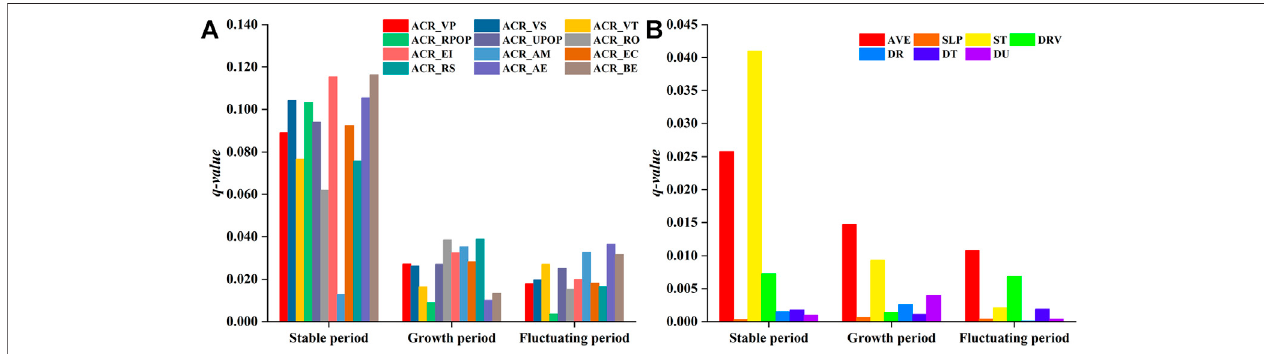
FIGURE 8 | The local driven mechanism of GCL at different periods: (A) factor detection for the local dynamic variables, (B) factor detection for the local stable variables.